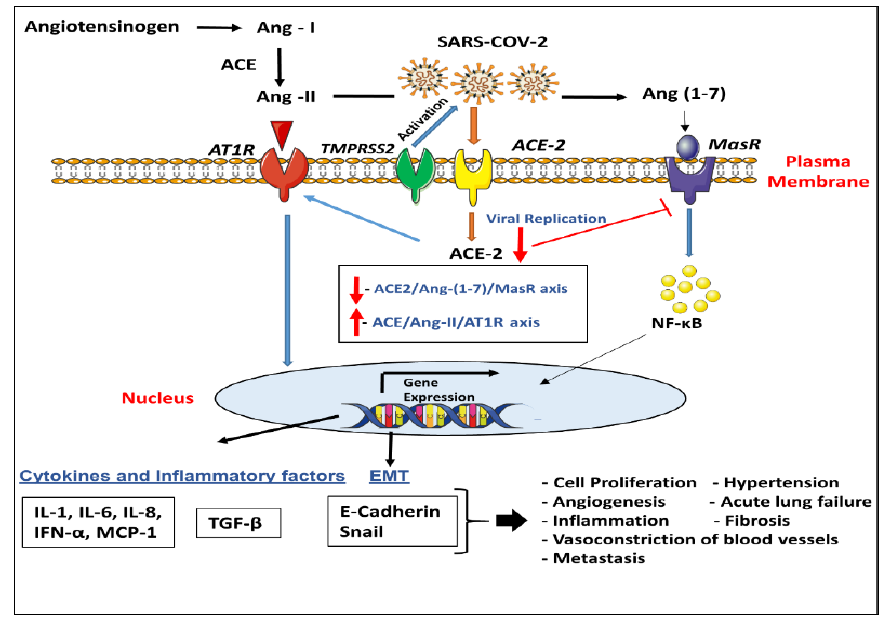
Figure 1. Schematic model for the effects of angiotensin converting enzyme II (ACE-2)/ transmembrane serine protease 2 (TMPRSS2) axis in severe acute respiratory syndrome coronavirus 2 (SARS-CoV-2) action and tumor lung tissues. Activation of renin–angiotensin system cascade potentially leading to angiotensinogen enzymatic cleavage to Angiotensin I (Ang- I). Additionally, increase ACE abundance will potentially enhance production of the biologically active Ang-II that may lead to increase activation of Angiotensin type 1 receptor (AT1R) upon Ang-II binding. ACE-2 converts Ang-I to Ang (1–7) which acts through Mas receptor to protect from acute lung failure promoted through AT1R activation. However, it is still unknown how it may also enhance tumor development by stimulating vascularization. On the other hand, the “spike” attachment protein for the current SARS-CoV-2 coronavirus uses the cellular attachment factor, ACE-2 and requires TMPRSS2 cell protease for activation. This scenario antagonizes the protective role of ACE-2 and thus leads to severe lung injury and acute lung failure. Together, these upregulations have the potential to mediate intracellular signaling pathways and stimulate the production of different cytokines, inflammatory, and growth components such as the formation of transforming growth factor (TGF)-β and NF-κB to promote tumorigenesis and epithelial–mesenchymal transition (EMT) properties including; proliferation, angiogenesis, fibrosis, migration, and invasion.